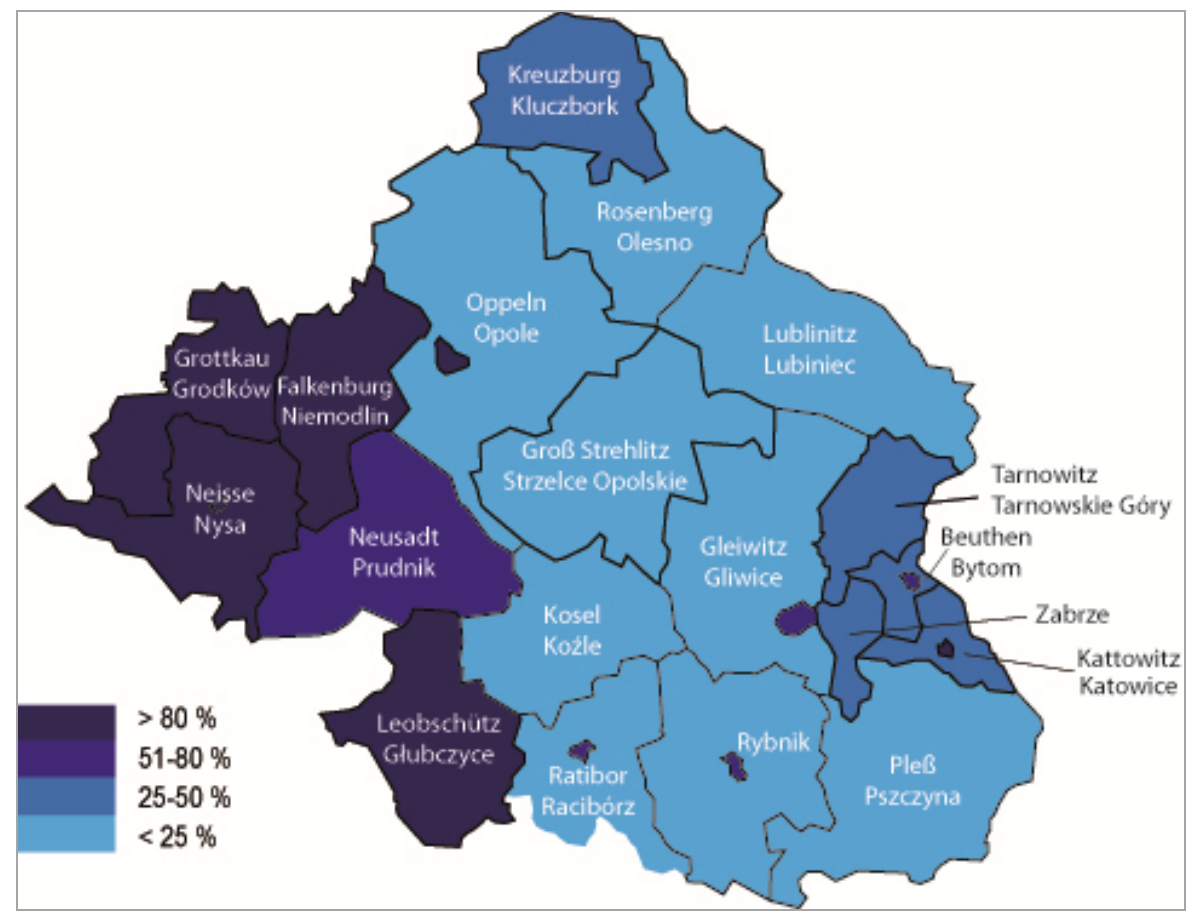
Fig. 3. German speaking population in Upper Silesia 1910 (source: own computation, based on 1910 Prussian census results) The partition caused population